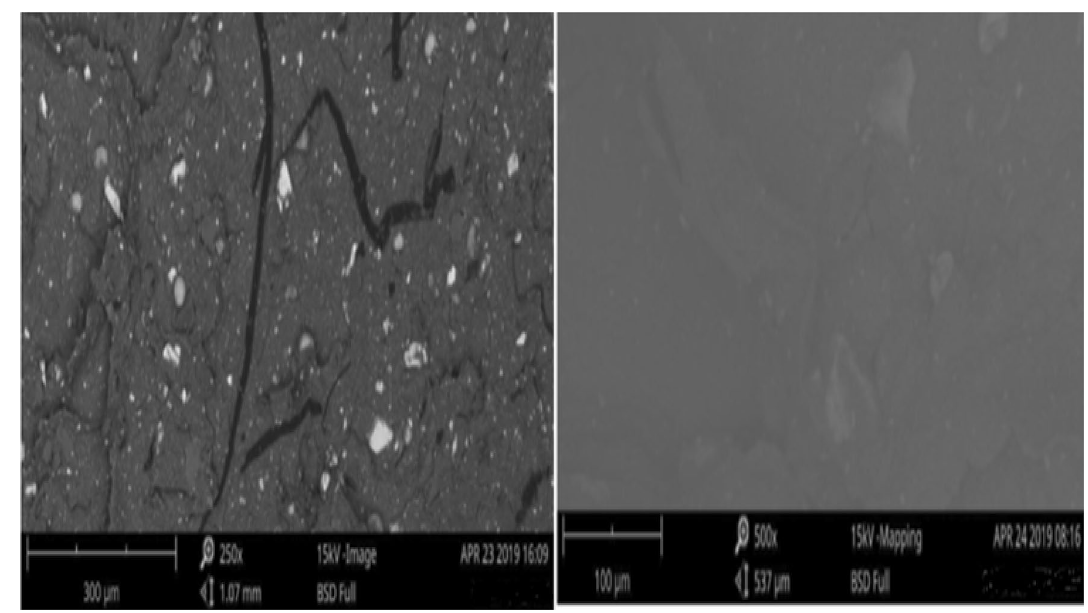
Fig. 7 SEM analysis of the filter cake morphology